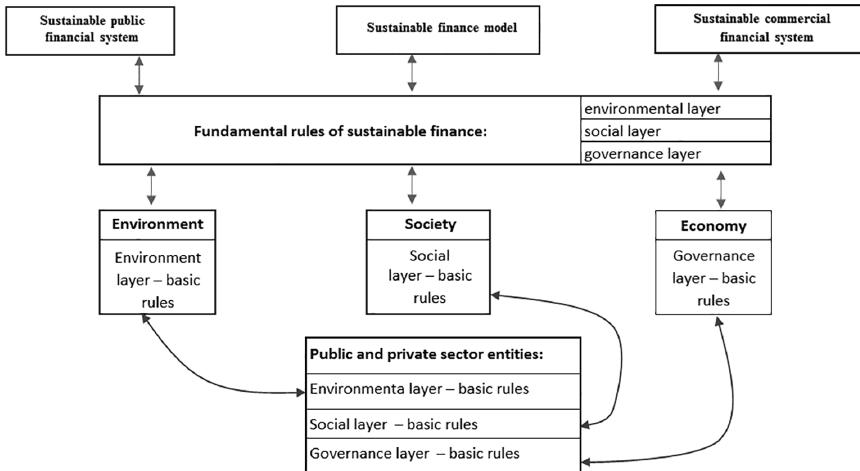
Figure 3. The triple layered sustainable finance model